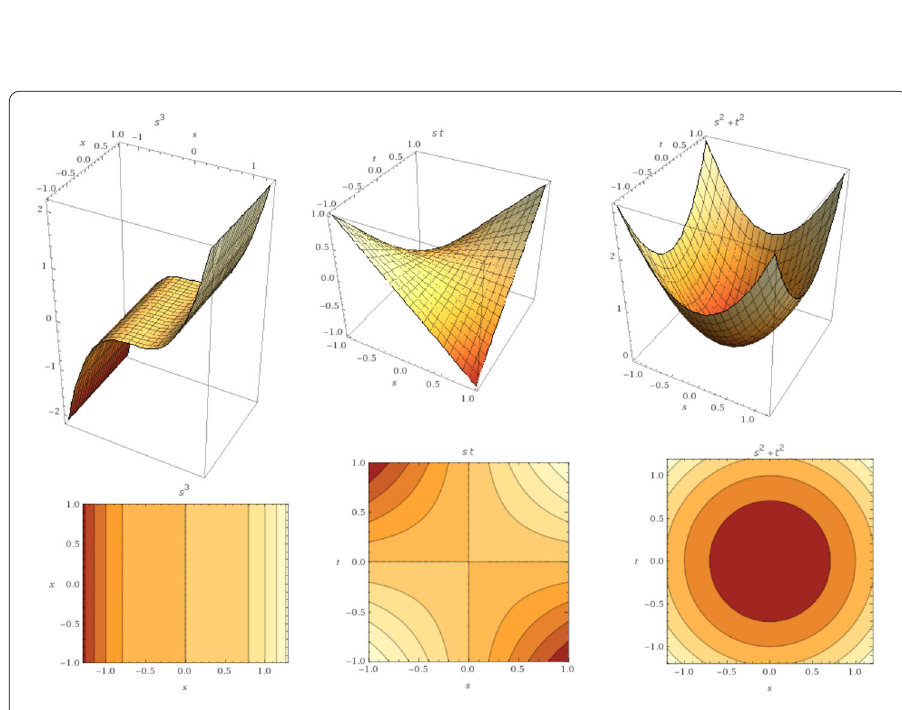
Figure 7 GB for the nonlinear case in Example 3.7